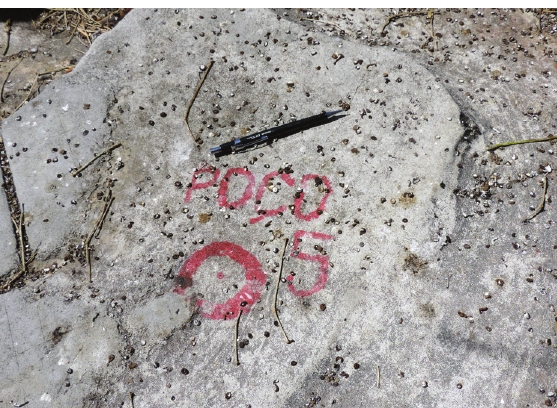
Figure 3 - One of the marks made with permanent paint to indicate a possible drill hole on one of the most important stromatolite geosites in Brazil. This denouncement by the scientific community indicating the imminent damage prevented the realization of the holes (Photo: Kátia Mansur,